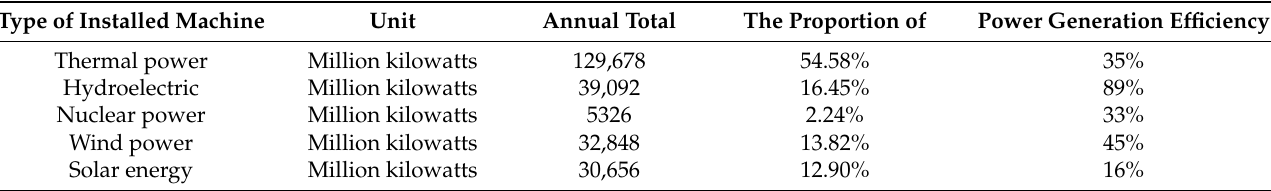
Table A2. China’s installed power generation capacity in